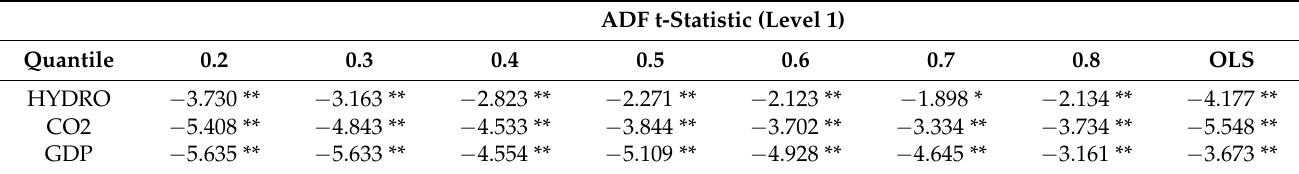
Table 1. Results from the quantile unit root test. ADF t-Statistic (Level 1)